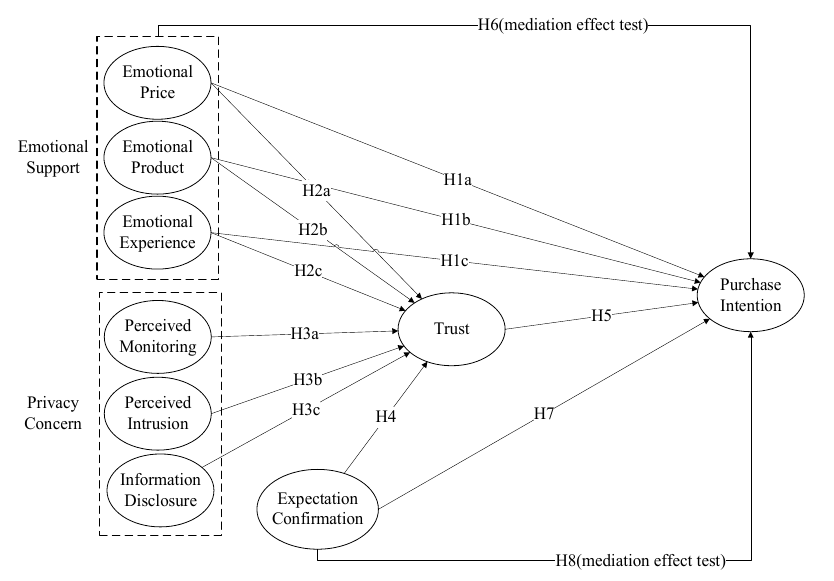
Figure 1. Theoretical model and hypotheses.